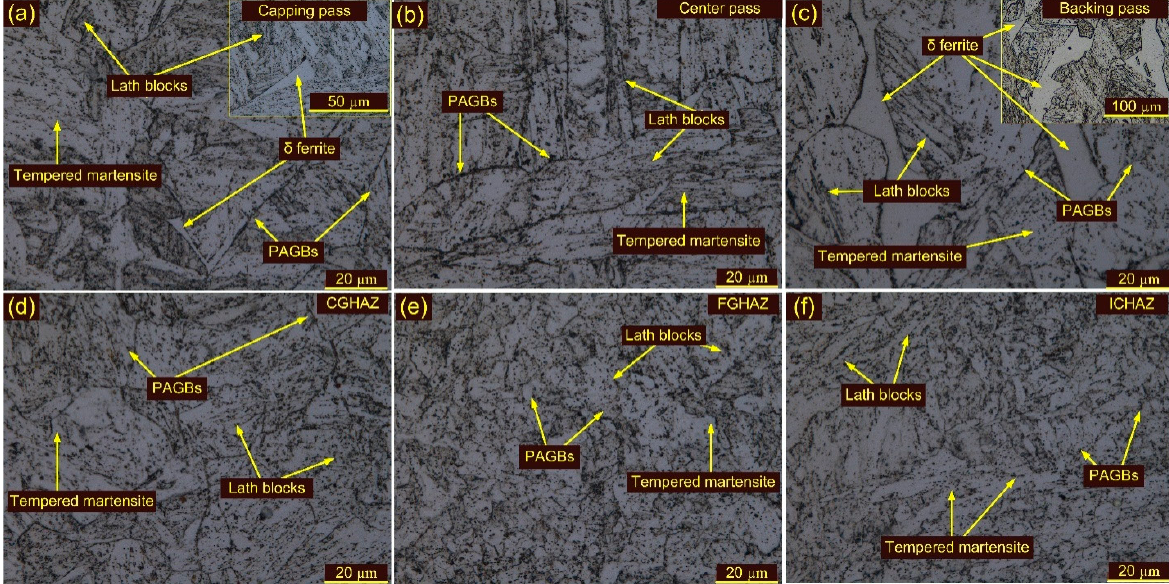
Figure 10. SEM images of weldments after T1 treatment: WFZ ( a ) capping pass, ( b ) center pass; ( c ) CGHAZ, ( d ) FGHAZ, ( e ) ICHAZ.